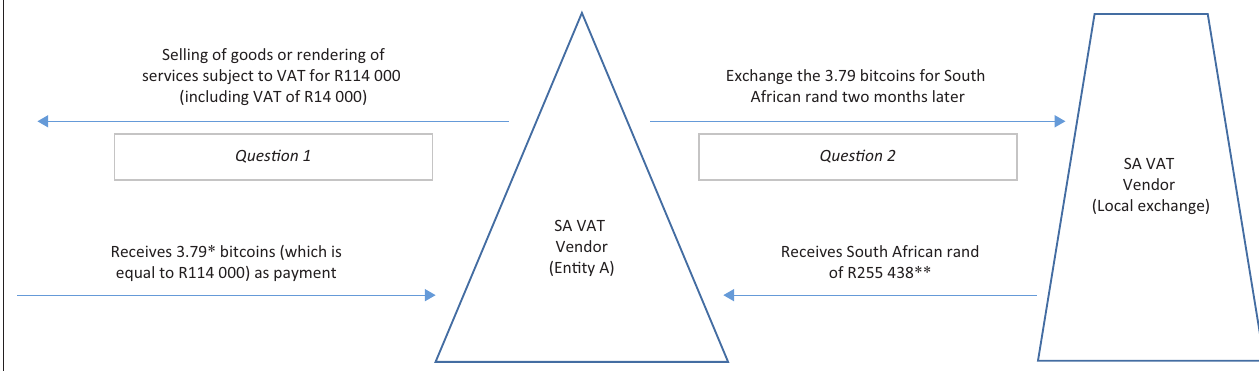
Source: Adapted from Bitcoin ZAR, n.d., South African Bitcoin resources: The official site [Online], viewed 17 May 2018, from https://www.bitcoinzar.co.za/ * , Value as on 20 June 2017; ** , Value as on 15 August 2017. VAT, value-added tax. FIGURE 2: Two research questions (with